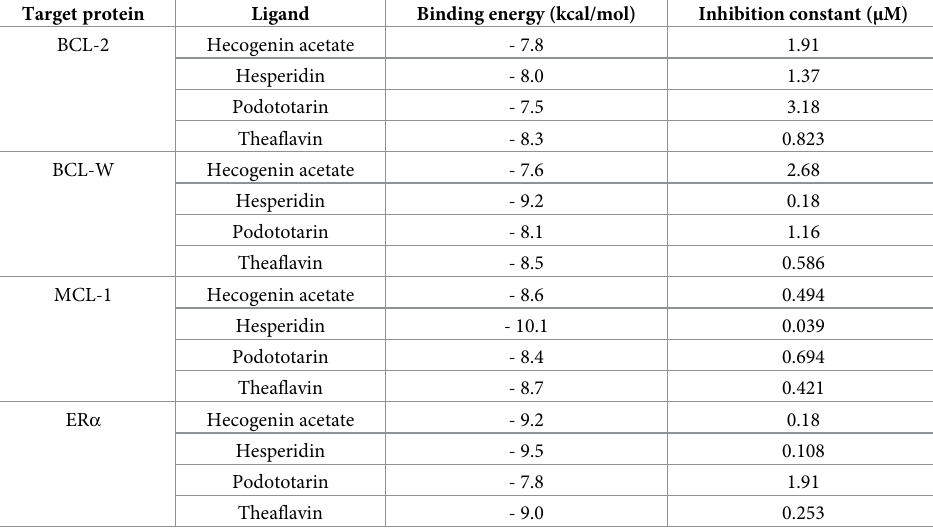
Table 2. The binding potency and inhibition constant of desired ligands with the target